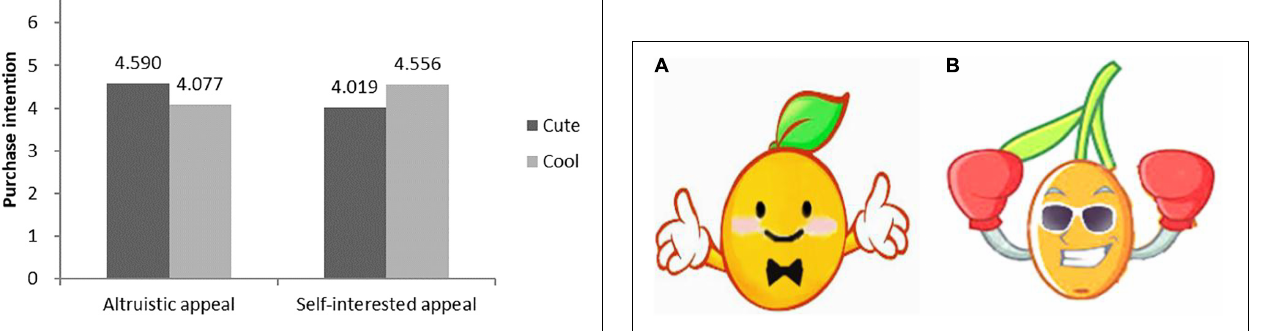
FIGURE 3 | The interaction of brand anthropomorphic images and advertising appeals.